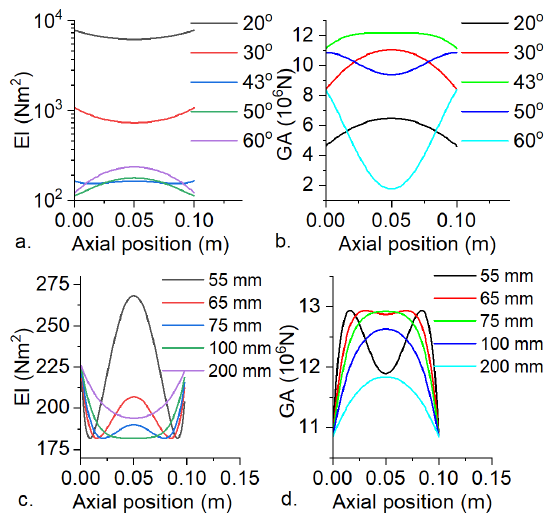
Figure 8: For an initial structure vector H 0 = [0.1, 0.1, 0.1, 40] , a) distribution of bending stiffness at different θ 0; b) distribution of shear stiffness at different θ 0 ; c) distribution of bending stiffness at different meridional radii; d) distribution of shear stiffness at different meridional radii.